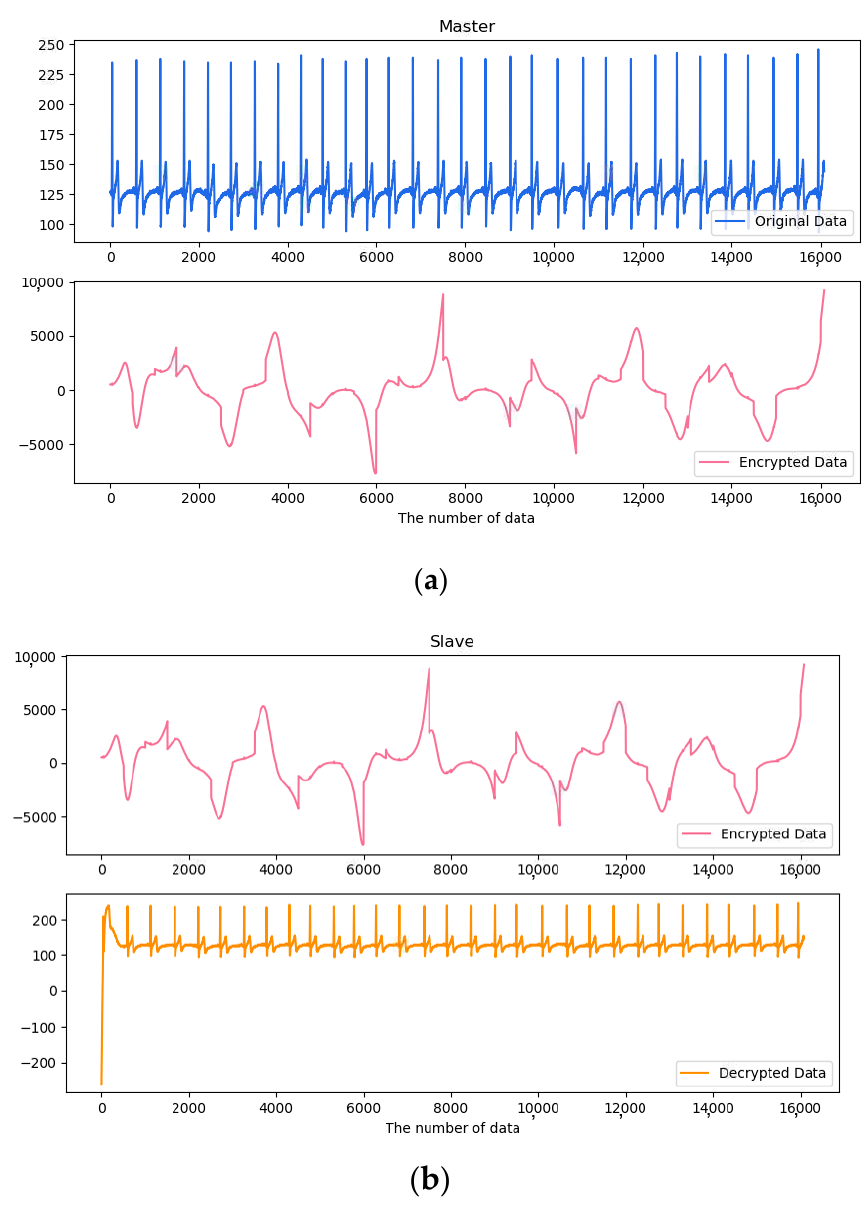
Figure 22. Implementation of ECG with RPi. ( a ) The data in the Master; ( b ) The data in the Slave.